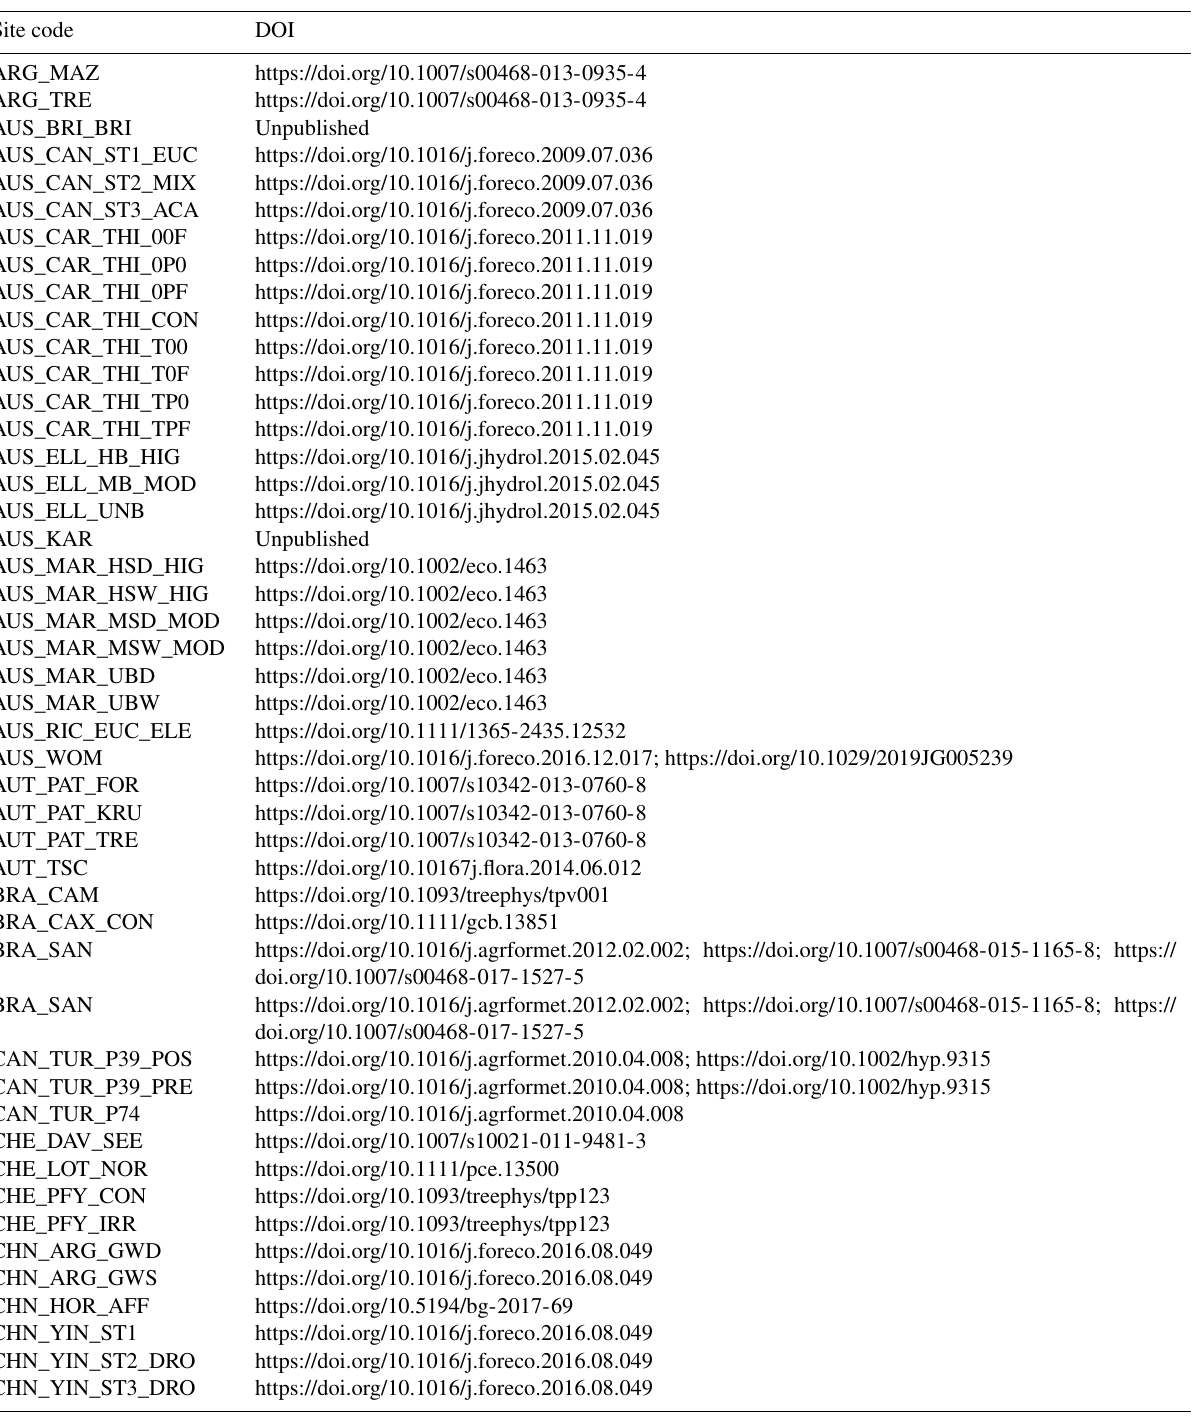
Table A1. SAPFLUXNET dataset codes and DOIs (digital object identifiers) of the publications associated with each dataset. Where no DOI was available, the bibliographic reference is shown. Some datasets may have no associated publication (“unpublished”). Site code DOI